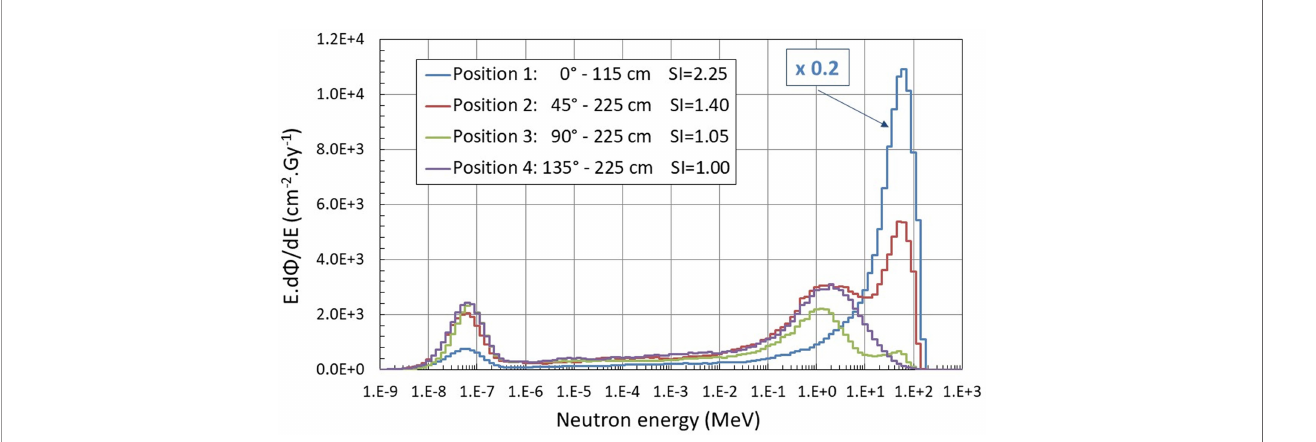
FIGURE 5 | Neutron spectra measured around the water phantom in Trento PTC using the extended-range Bonner sphere spectrometer (13). Additionally, spectral index (SI) values calculated as ratio of H *(10) measured with a high-energy extended rem counter NM2B-495Pb and a conventional NM2B-458 are indicated.